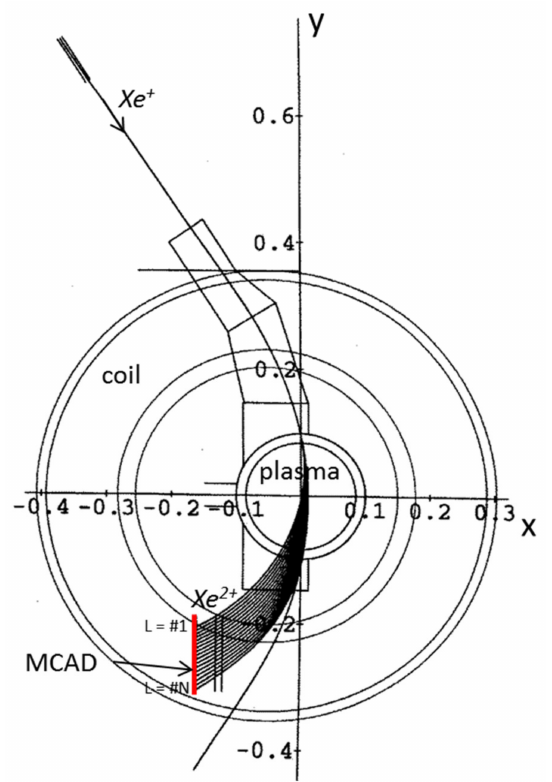
Figure 5. Trajectories (units in m ) of a 22 keV primary Xe+ beam and corresponding cloud of secondary beams as calculated by the HIBD modeling code for the tokamak ISTTOK ( B T = 0.48 T). The detector, represented by the red line, has N rows in total, each indexed by the number L (#1, . . . , #N) (reprinted from